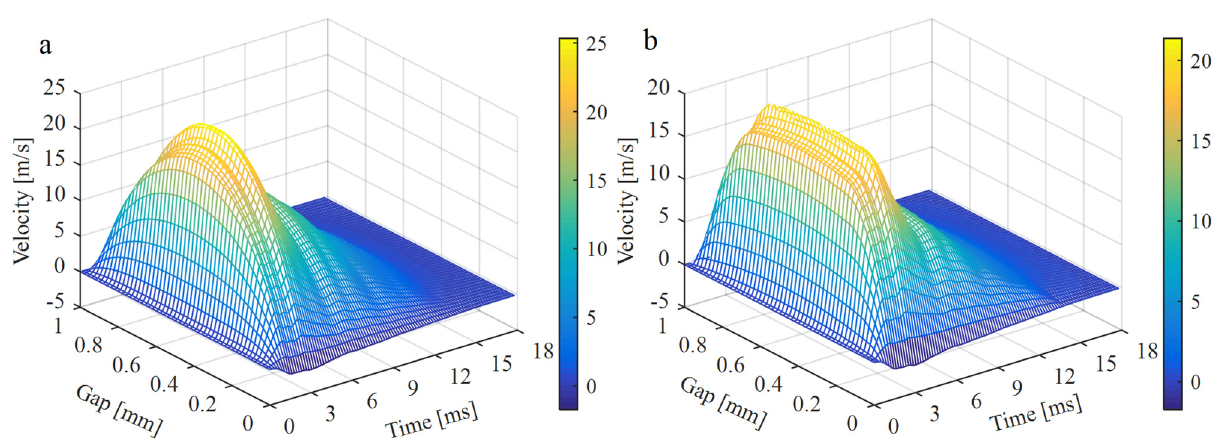
Figure 18. Space-time dynamic distribution of the MR fluid velocity in the inactivated and activated regions for the 2 A excitation current.